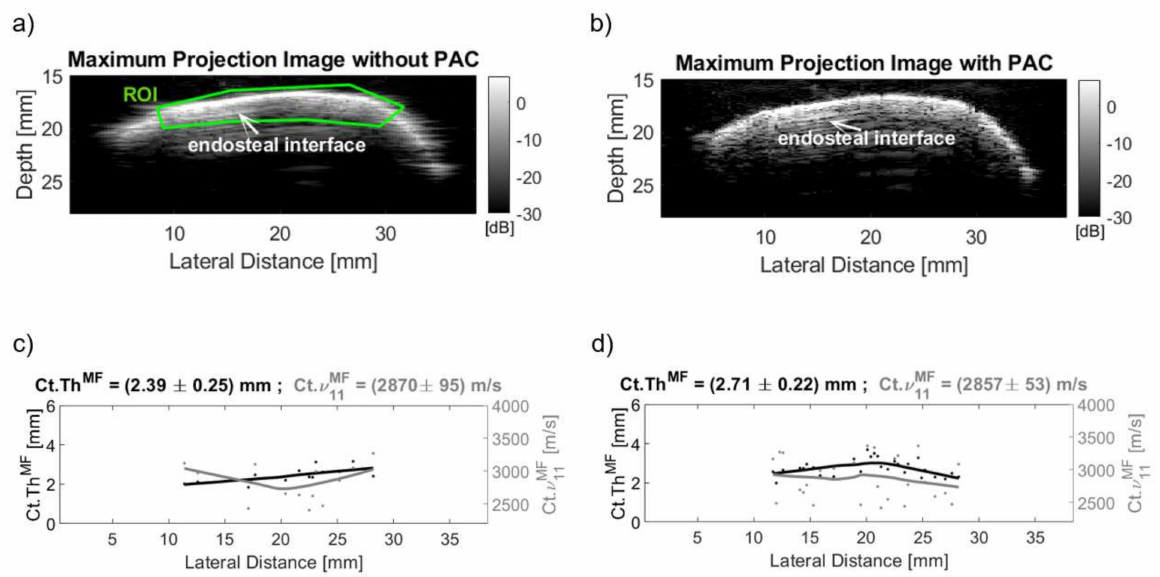
Figure 3. ( a ) Maximum projection B-mode image of human tibia bone at the central anteromedial region. The image was reconstructed and spatially compounded (by means of maximum projection) from measurements at all focus depths using conventional DAS beamforming. The range of interest (ROI) was manually selected (green lines). ( b ) Maximum projection B-mode image reconstructed from all focus depths with PAC (ST, ACF, CC). ( c ) Representative plots of Ct . Th MF (x i ) and Ct. ν 11 MF ( x i ) without PAC and ( d ) with PAC. The dots indicate the estimations for each individual lateral scan position x i , and the straight lines are the estimations using a moving average filter. Means and standard deviations were determined from smoothed data. The number of individual scan positions contributing to the parameter estimations in ( c , d ) were 14 and 29,